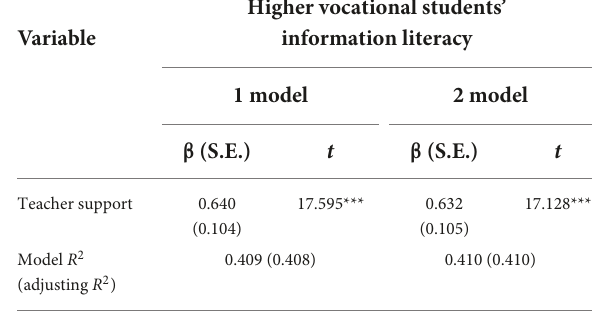
TABLE 2 Correlation analysis results of teacher support, usefulness of network perception, ICT self-efficacy and information literacy of higher vocational students.